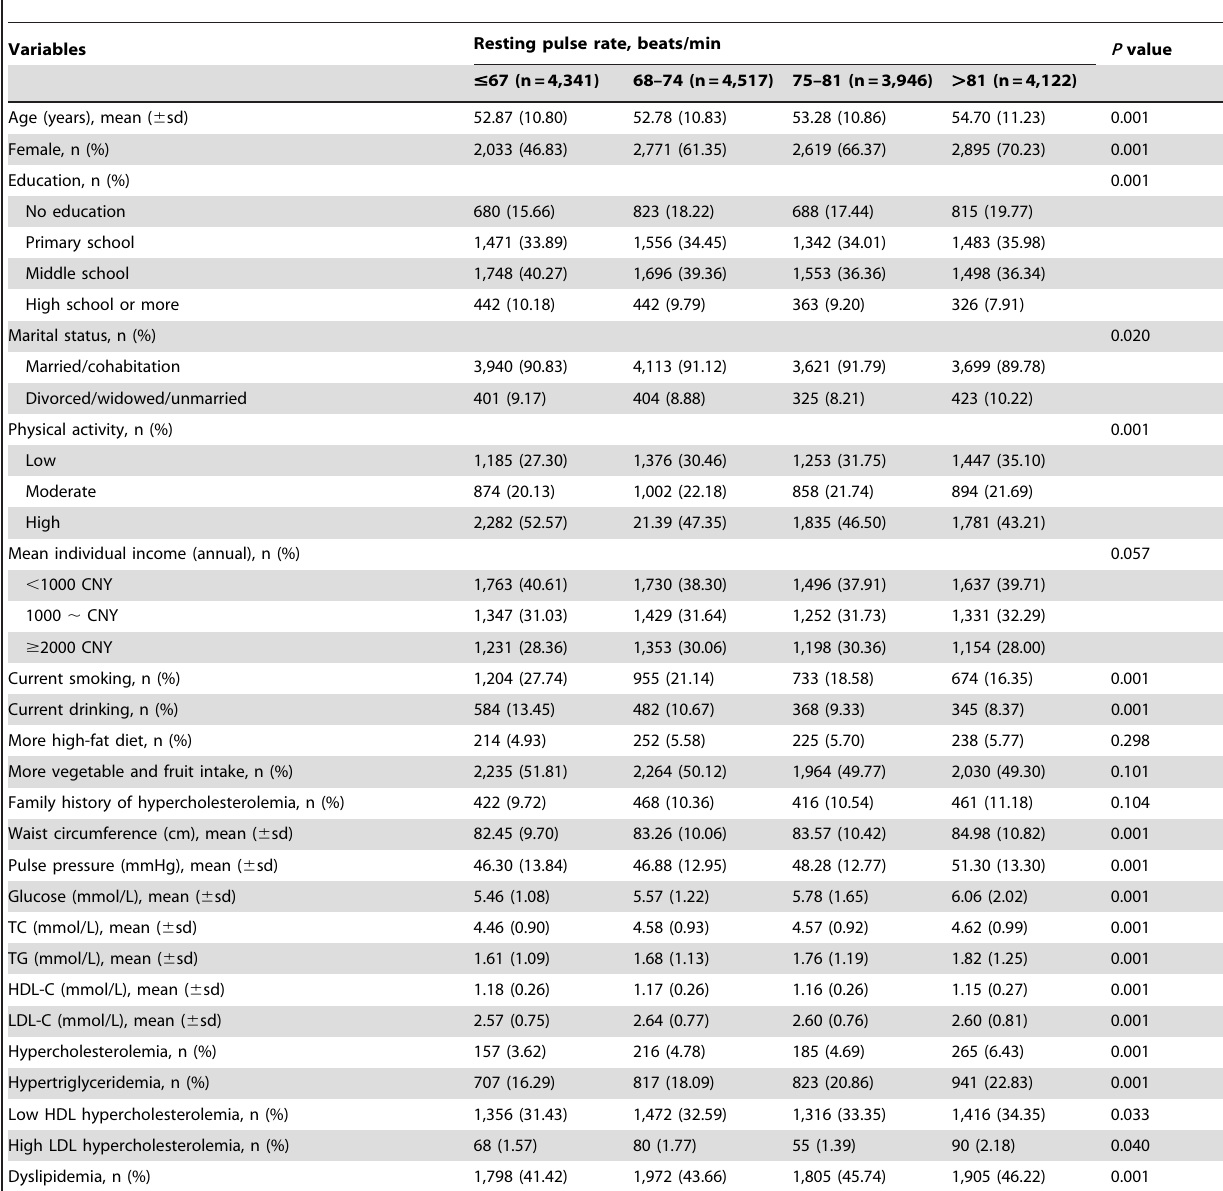
Table 1. Characteristics of study population stratified by resting pulse rate (n=16,926).